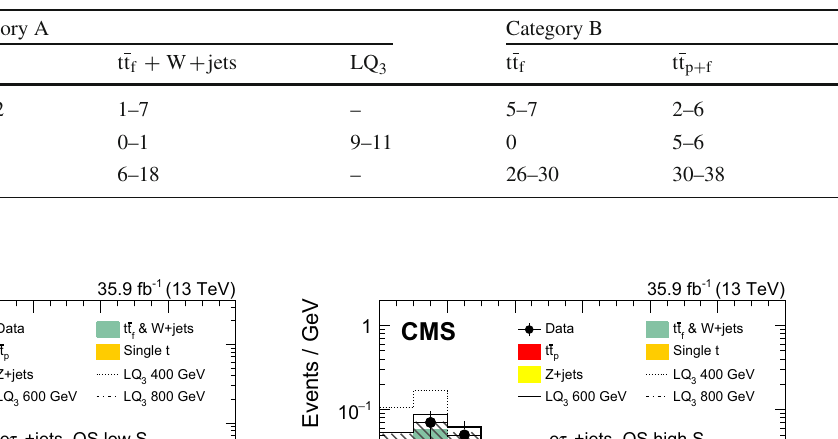
Table 2 Summary of largest systematic uncertainties for the tt f (and W + jets) and tt p + f backgrounds derived from data, for the tt p back- groundobtainedfromsimulationandforaleptoquarksignalwithamass